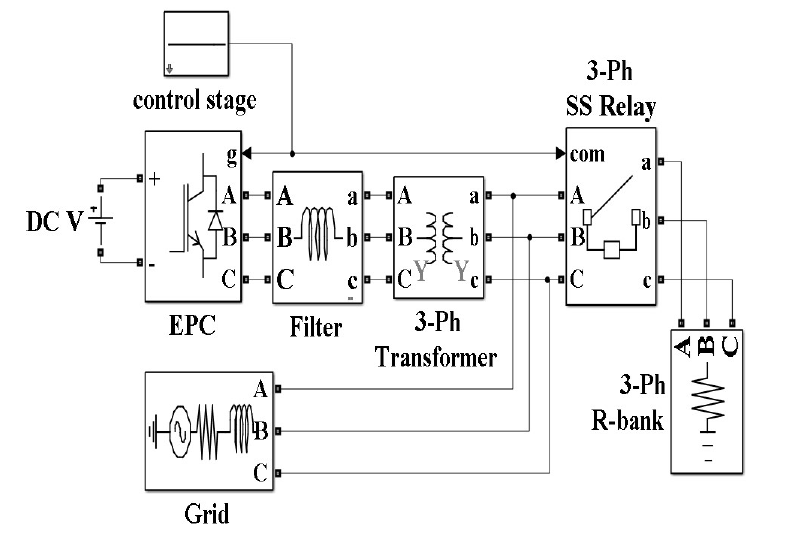
Figure 7. Connection diagram to generate a step in the d component of the output voltage V od